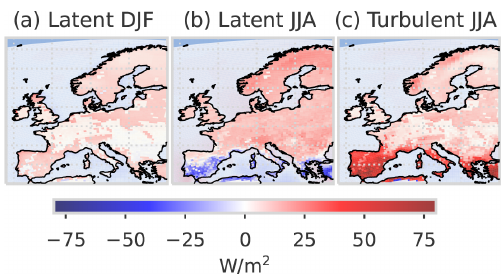
Figure 4. Mean differences between CARBON and GRASS for the latent heat fluxes in (a) winter and (b) summer for the period 1986– 2015. The differences in the sum of all turbulent heat fluxes (latent + sensible) in summer is shown in (c)